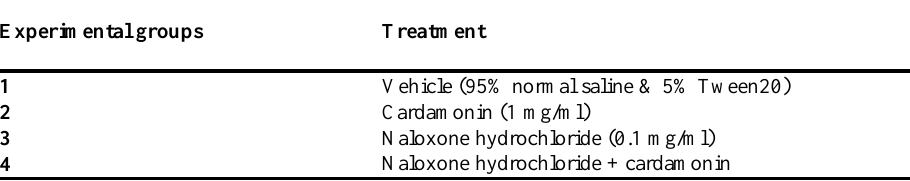
Table 2: Experiment II – Involvement of opioid